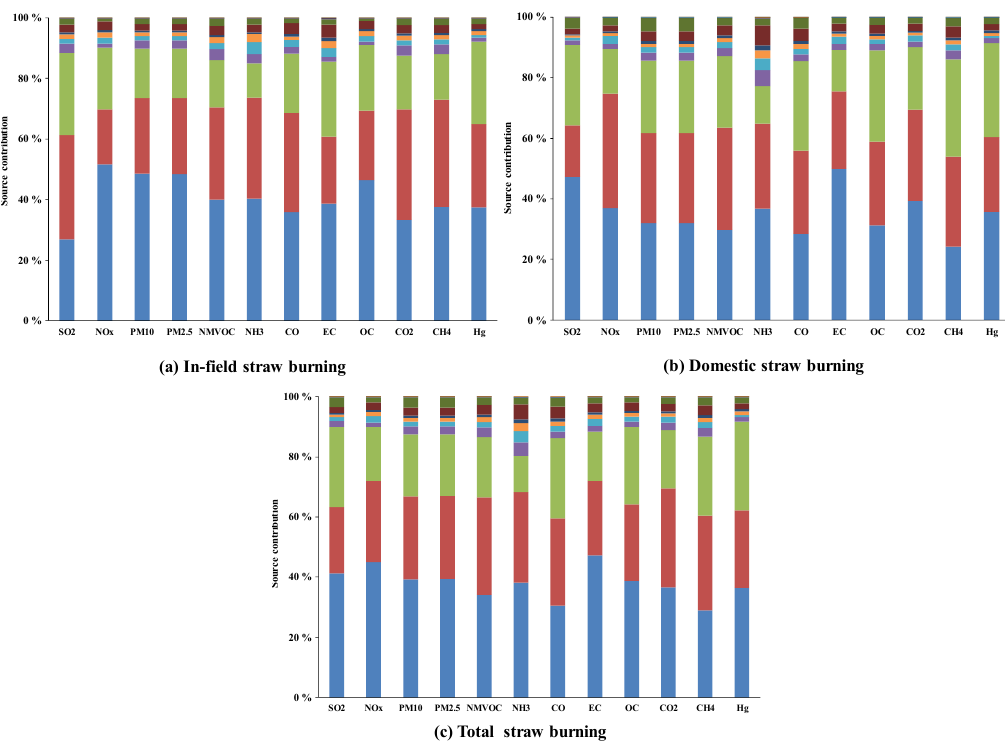
Figure 3. Contributions of 12 crop straw types for various pollutants in China in